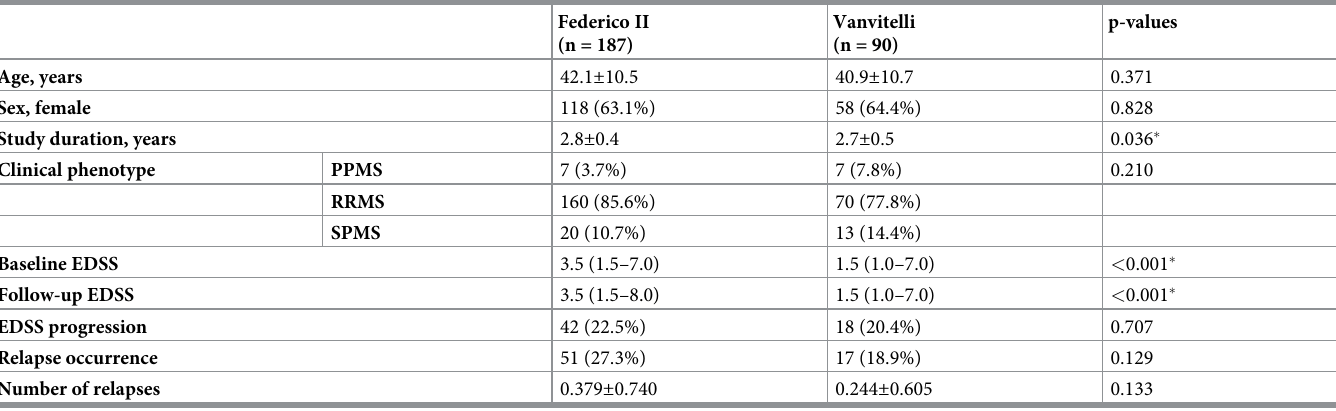
Table 1. Demographic and clinical characteristics.